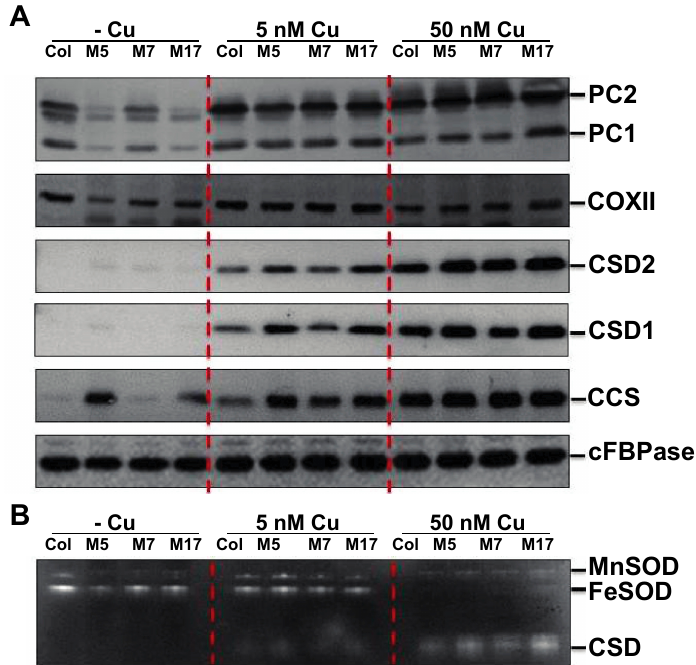
Figure 5. Comparison of Cu protein accumulation in wild-type (Col) and three transgenics (M5, M7, M17). ( A ) Western-blot analysis using the following antibodies: PC, plastocyanin two isoforms (PC2 and PC1 are detected); COXII, cytochrome-c oxidase subunit II; CSD2 and CSD1 (chloroplast and cytosolic isoforms of Cu/Z superoxide dismutase; and CCS, copper chaperone for Cu/ZnSOD. cFBPase was used as a loading control. Total soluble proteins (30 µg) were fractioned using SDS-PAGE (15% gel) and blotted onto nitrocellulose membranes. ( B ) For SOD isoform activity, total soluble proteins (30 µg) were fractioned on a non-denaturing 15% acryl amide gel and stained for SOD activity. The indicated detected isoforms were identified based on known relative mobility.